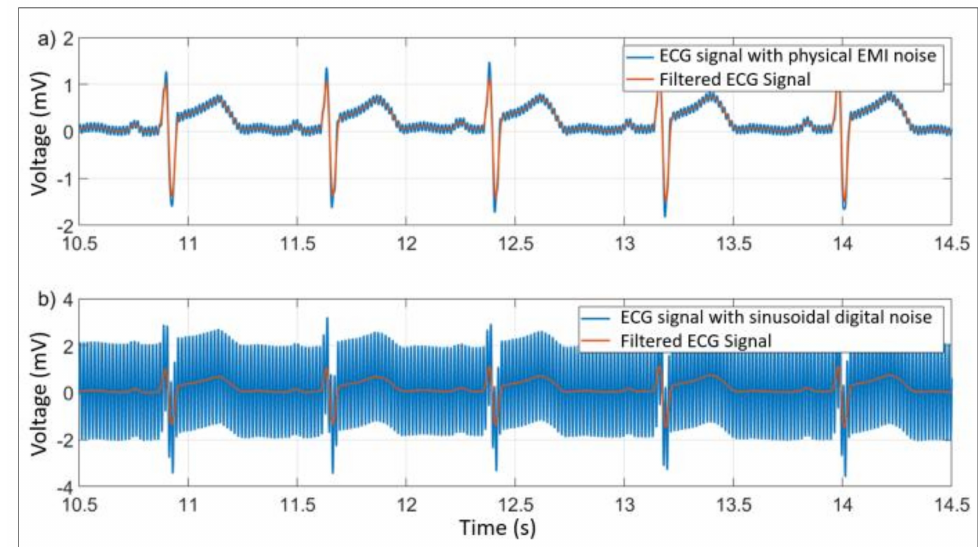
Figure 19. ECG signals with EMI noise ( a ) and sinusoidal noise ( b ).